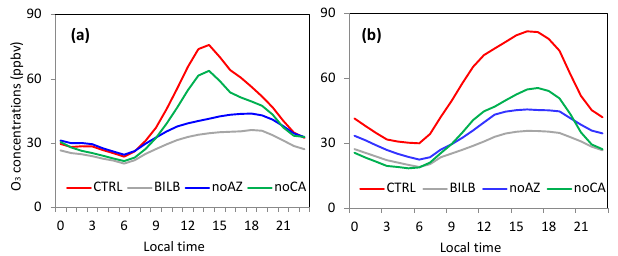
Figure 5. Simulated diurnal variations of [O 3 ] at Phoenix ur- ban setting for different emission scenarios: (a) average from 16– 19 July 2005, and (b) average from 11–14 May 2012.